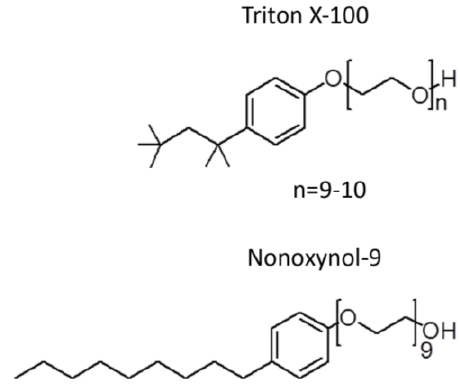
Figure 1. Similarity of the chemical structure of nonoxynol-9 and Triton X-100.